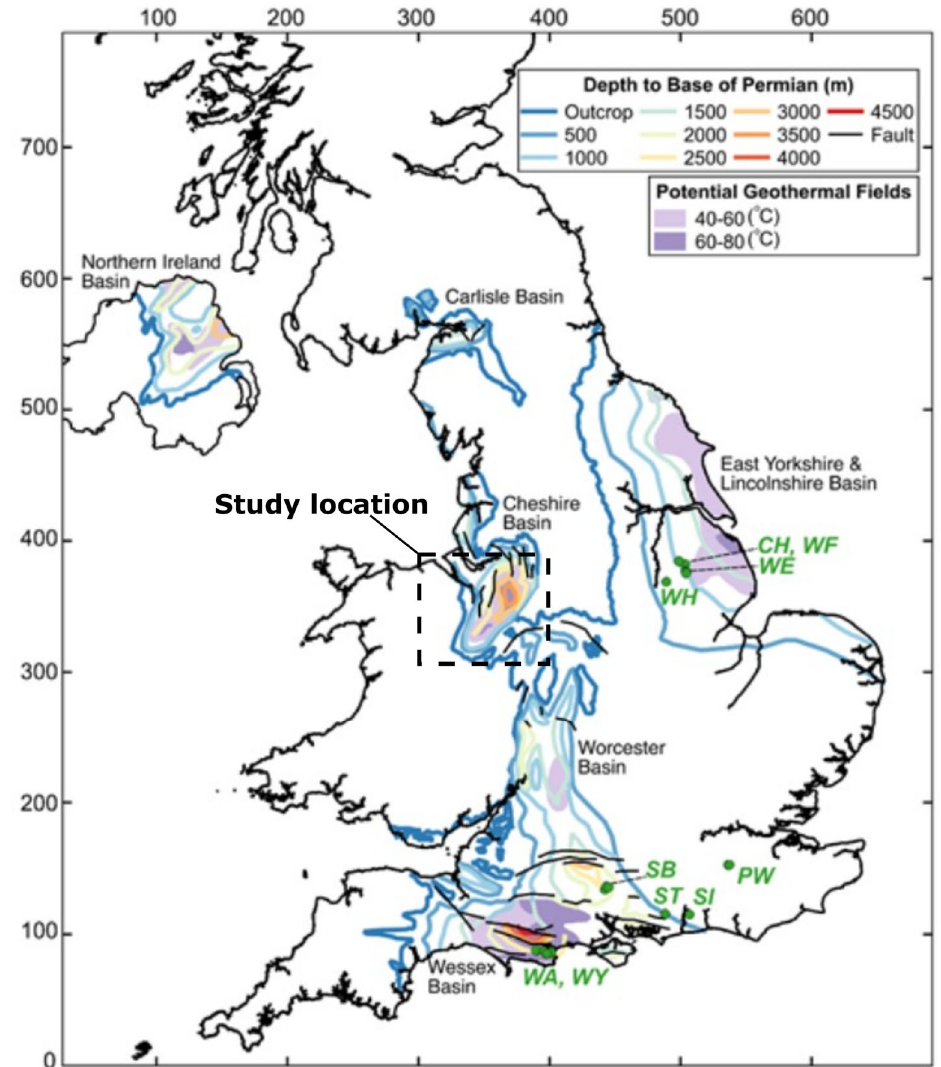
Figure 1. Map of the UK highlighting Permo-Triassic basins and temperature fields. Modified from Watson et al. [5], who digitized the map after Downing and Gray [13]. Note the green dots are associated to oil and gas fields. Grid coordinates are in 100 km intervals for north and east.